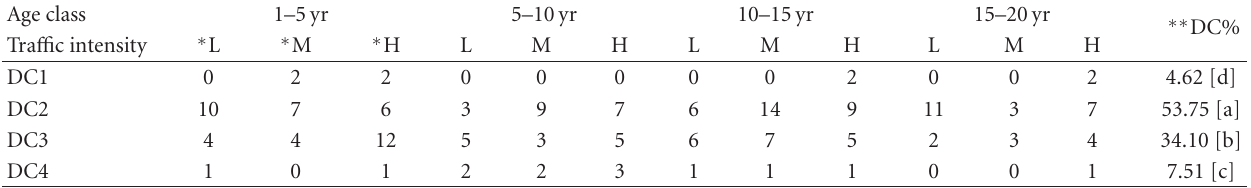
Table 4: Distribution of damaged trees based on location of wound on trees’ stems.